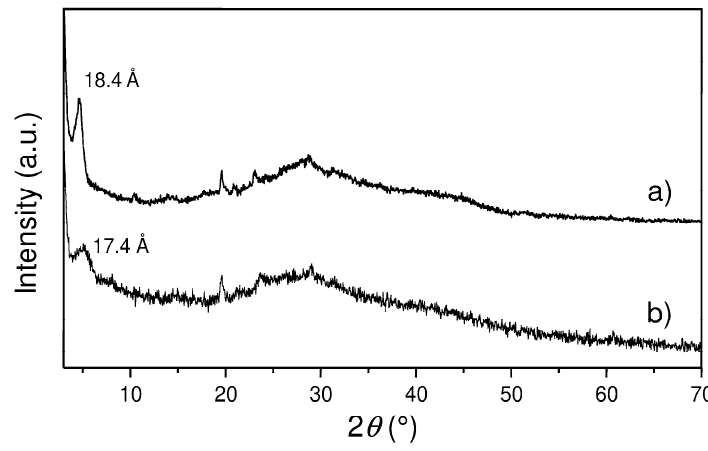
Figure 5. XRPD pattern of Zn/ZG (a); pristine ZG-e (b).